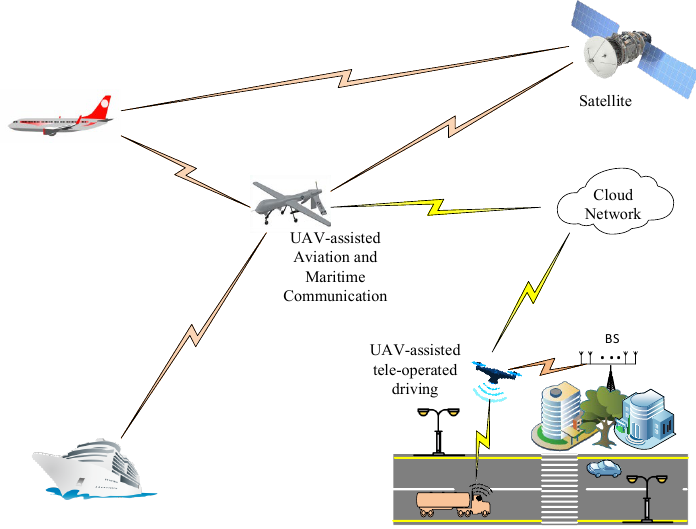
Figure 6. UAV/CubeSat facilitated ubiquitous